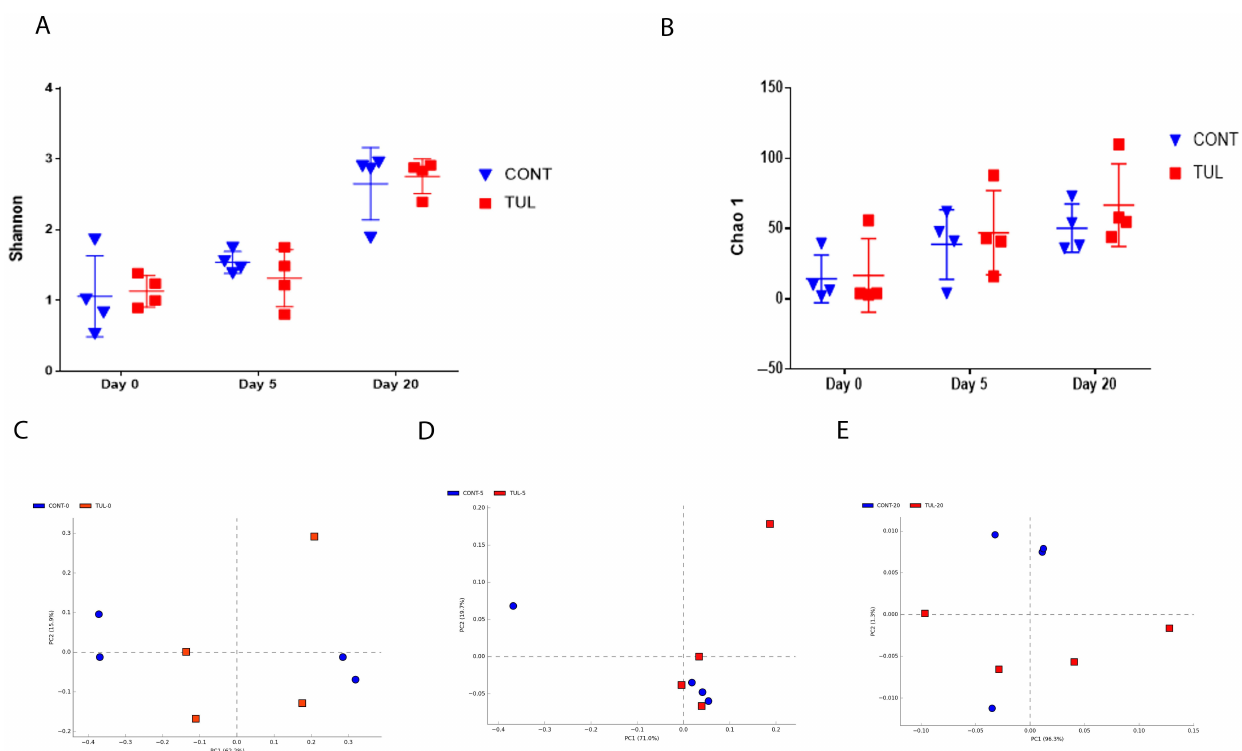
Figure 1. ( A ) Shannon diversity of the control (CONT) and tulathromycin (TUL) gut archeome at 0, 5, and 20 days of life. ( B ) The difference in the Chao 1 index measured between the CONT and TUL groups at different sampling days (0, 5, and 20). Principal component analysis (PCA) based on the non-phylogenetic Bray–Curtis distance metrics for CONT and TUL at days 0 ( C ), 5 ( D ), and 20 ( E ).